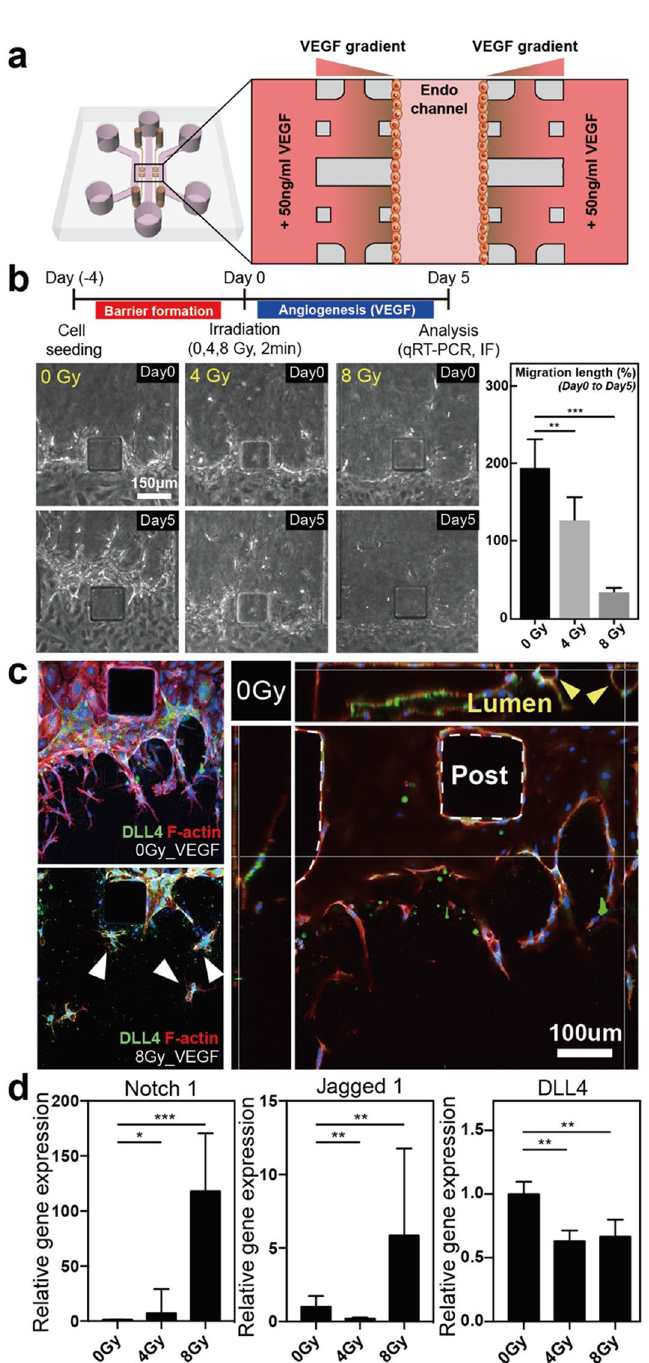
Figure 5. Schematic overview for inducing angiogenesis with VEGF gradient and defective angiogenesis in gamma-irradiated endothelial monolayer ( a ) By adding an additional 50 ng/mL of VEGF-A into the side channels, a gradient of VEGF-A was generated between the side channels and the central channel. ( b ) After the gamma irradiation treatment, endothelial monolayers were induced to angiogenesis for 5 more days. The endothelial monolayer that was exposed to high-dose (8 Gy) gamma irradiation showed a reduced cell migration into the hydrogel in comparison to the non-irradiated one. (n = 3) ( c ) In addition, the immunofluorescence images showed disrupted lumen structures in the gamma-irradiated endothelial monolayer. ( d ) Relative gene expressions for Notch1, Jagged1, and Dll4 showed large gaps among the non- and irradiated endothelial cells (scale bar: 100 and 150 µm; * p < 0.05; ** p < 0.01; *** p < 0.001, n = 2–3). Statistical comparison were calculated with two-tailed t-tests using Prism (7.0a, GraphPad software, www. graph pad. com). Adobe illustrator (CC 2019 23.0.1, www. adobe. com) was used for creating schematic, phase-contrast images, immunofluorescence images and